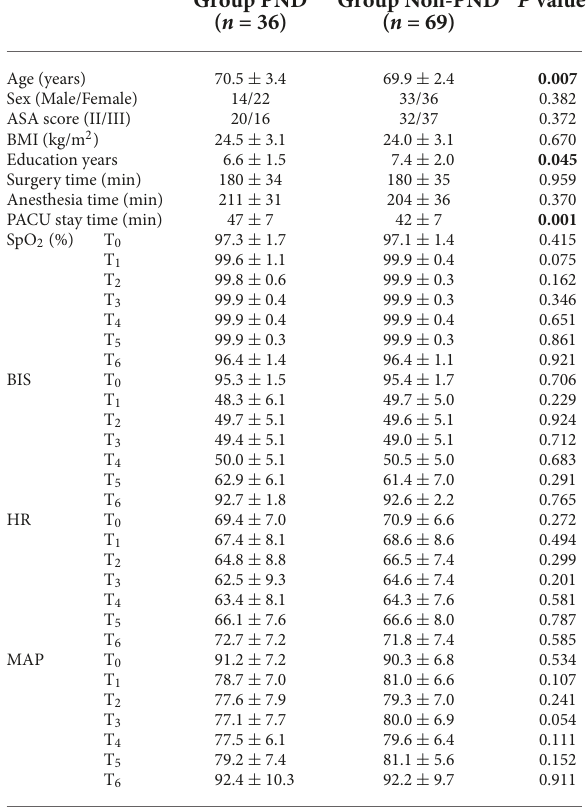
TABLE 3 Characteristics of the patients, surgery, and anesthesia in the group PND and group Non-PND. Group PND Group Non-PND P value ( n = 36)